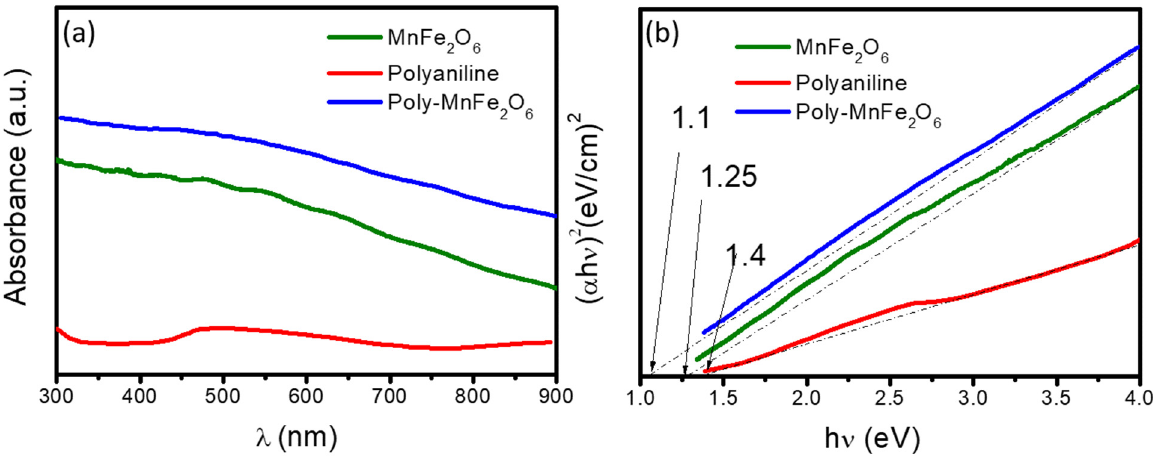
Figure 3. Visible light absorbance ( a ) and bandgap ( b ) of PANi, MnFe 2 O 4 and polyaniline@MnFe 2 O 4